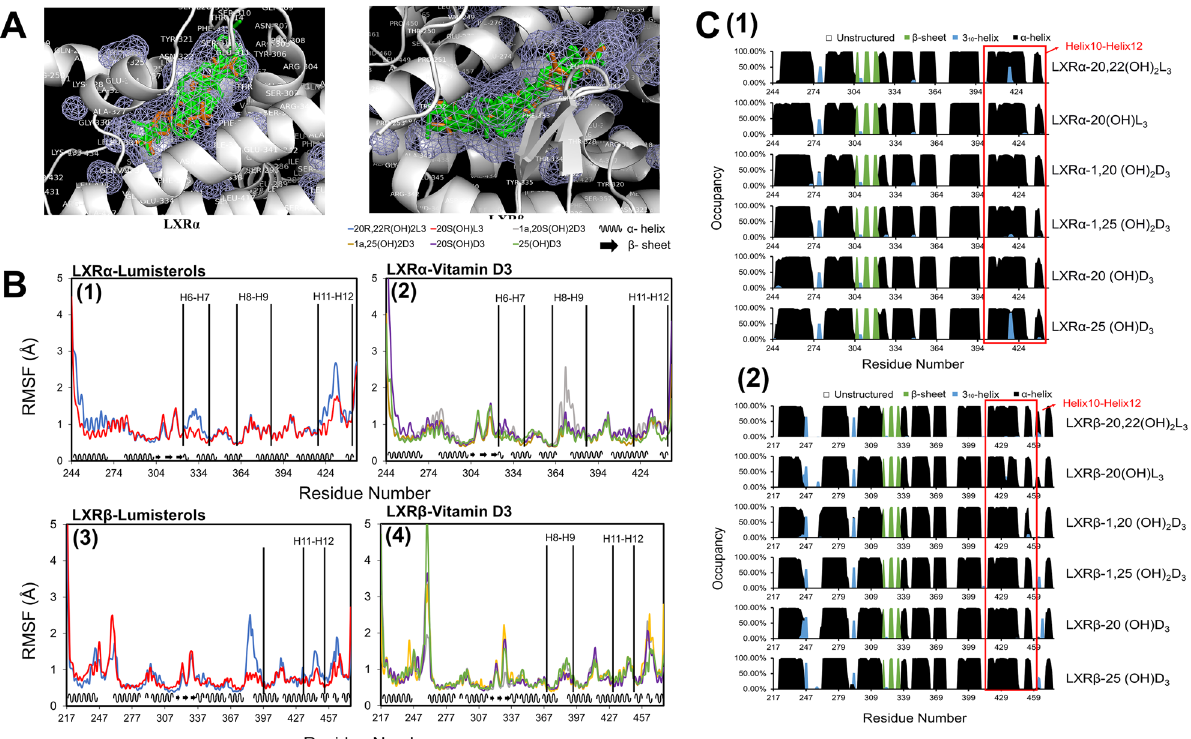
Figure 7. ( A ) Binding modes for the selected four D3 derivatives (1,20(OH) 2 D3, 1,25(OH) 2 D3, 20(OH)D3, and 25(OH)D3) and two L3 derivatives (20,22(OH) 2 L3, 20(OH)L3) and co-crystalized ligands in the ligand binding domain (LBD) of LXRα (PDBID:5AVI) and LXRβ (PDBID:5HJP). Docked poses of the studied ligands are shown in green and the co-crystallized ligands in LXRα and in LXRβ are shown in light brown. The mesh areas shown in the figure are hydrophobic binding regions in LXRs. ( B , C ) are based on last 150 ns of the equilibrated MD trajectories ( B ) Different L3 and D3 derivatives resulted in varied degrees of conformational fluctuation for the residues between helices in the LBDs of LXRα and LXRβ. ( C ) Different L3 and D3 derivatives could result in the small secondary structure changes of helix 10 to helix 12 for both LDB of LXRα and LXRβ. Image for ( A ) is made with PyMOL (v2.4.0, https:// pymol. org/2/) 99 based on our molecular docking results. Image for ( B ) is made with Microsoft Excel (v2019, https:// office. micro soft. com/ excel) 100 based on the root mean square fluctuation (RMSF) analysis of our molecular dynamics simulation trajectories. Image for ( C ) is made with Microsoft Excel (v2019, https:// office. micro soft. com/ excel) 100 based on the secondary structural analysis of our molecular dynamics simulation trajectories.